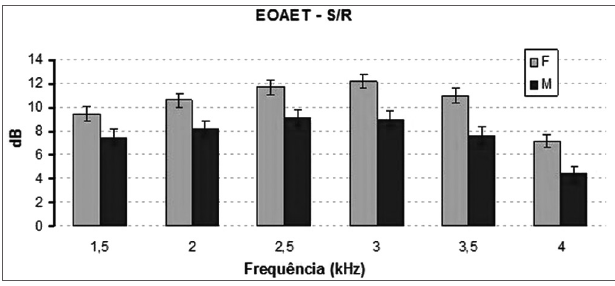
Figura 3. Média e desvio padrão das relações sinal/ruído das EOAT registradas para cada gênero em cada frequência. S/R: relação sinal/ ruído; F: Feminino; M: Masculino. Teste ANOVA, p < 0,001.